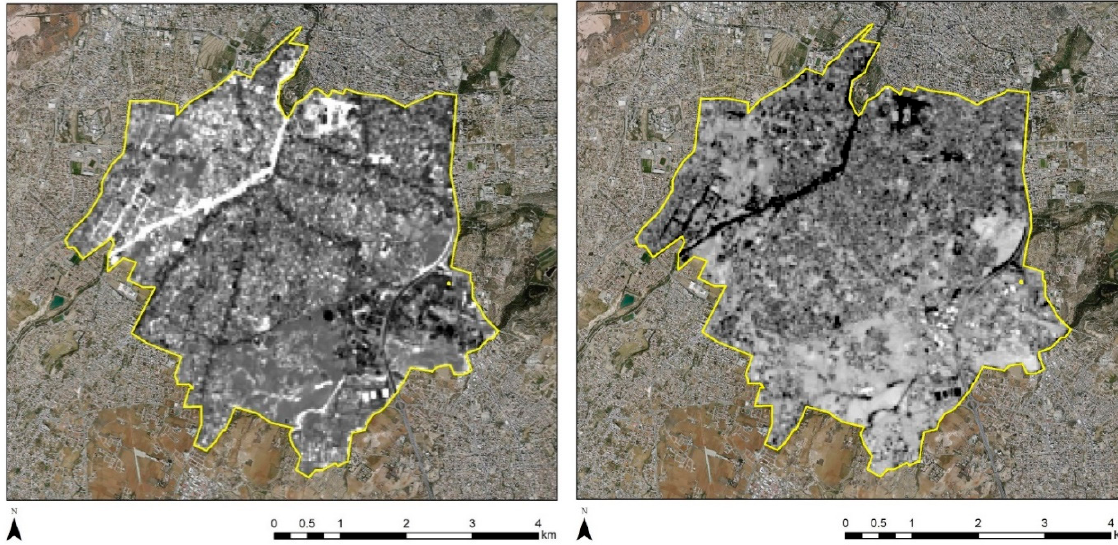
Figure 10. PCA analysis for the NDVI ( left ) and the NDBI ( right ) over the Strovolos case study.